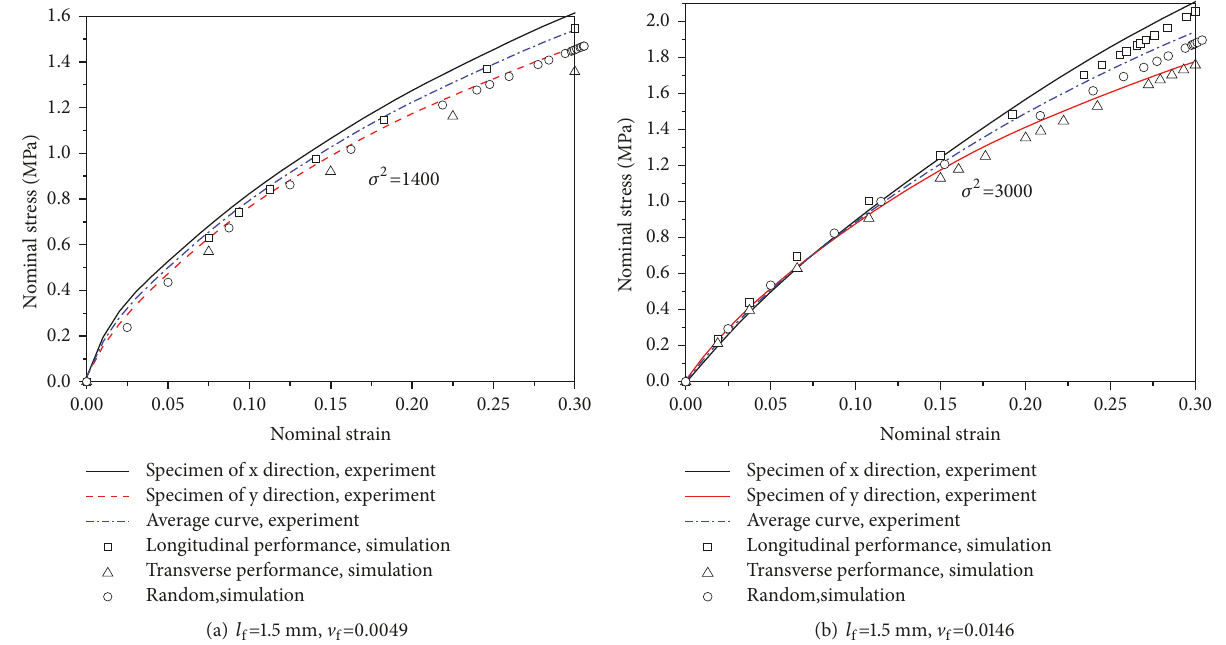
Figure 14: Comparison between the experimental and numerical results of the model with the determined 𝜎 2